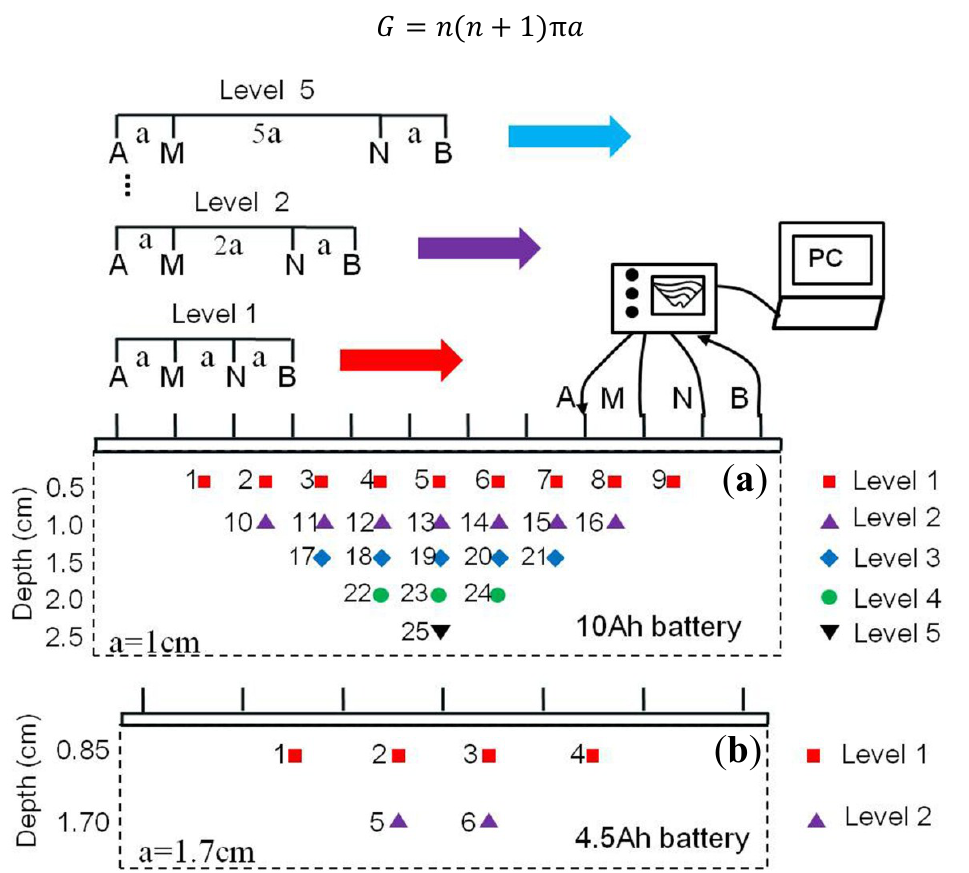
Figure 2. Distribution of blocks from multi-electrode probe measurements based on Schlumberger configuration. ( a ) Twenty-five blocks in five levels obtained from 12 electrodes for 10 Ah battery; ( b ) Six blocks in two levels obtained from seven electrodes for 4.5 Ah